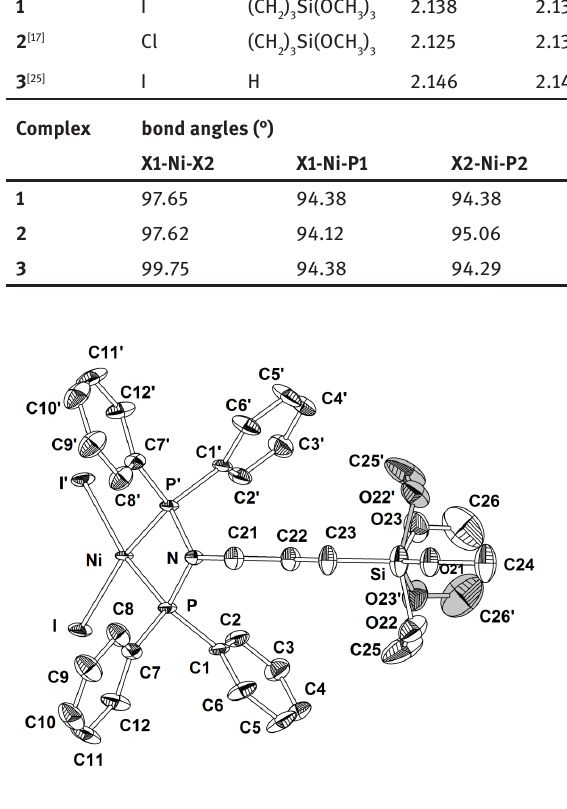
Figure 1: Molecular structure and atom numbering of complex 1 (ORTEP diagram, 50% thermal ellipsoids). The hydrogen atoms are omitted for clarity. The atoms at the disordered sites are shown in gray. Symmetry code: (′): -0.5-x,y,z. The structure has a mirror plane of symmetry, passing through the atoms: Ni, N, C21, C22, C23, Si, O21 and C24.